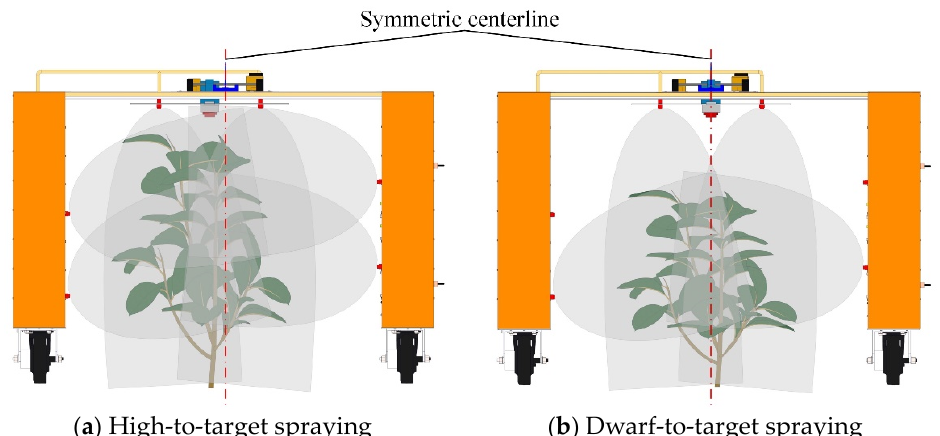
Figure 2. Schematic diagram of the targeted and variable spray.